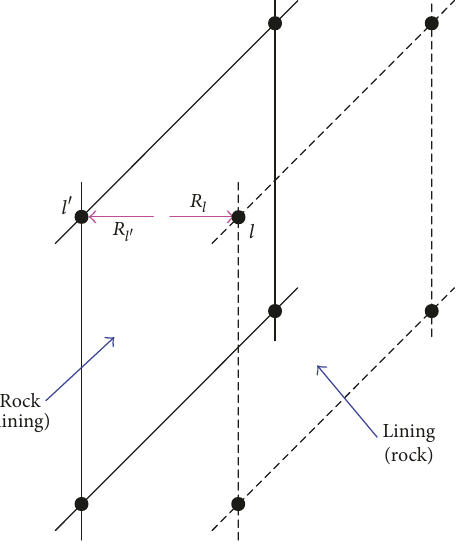
Figure 3: Point to point